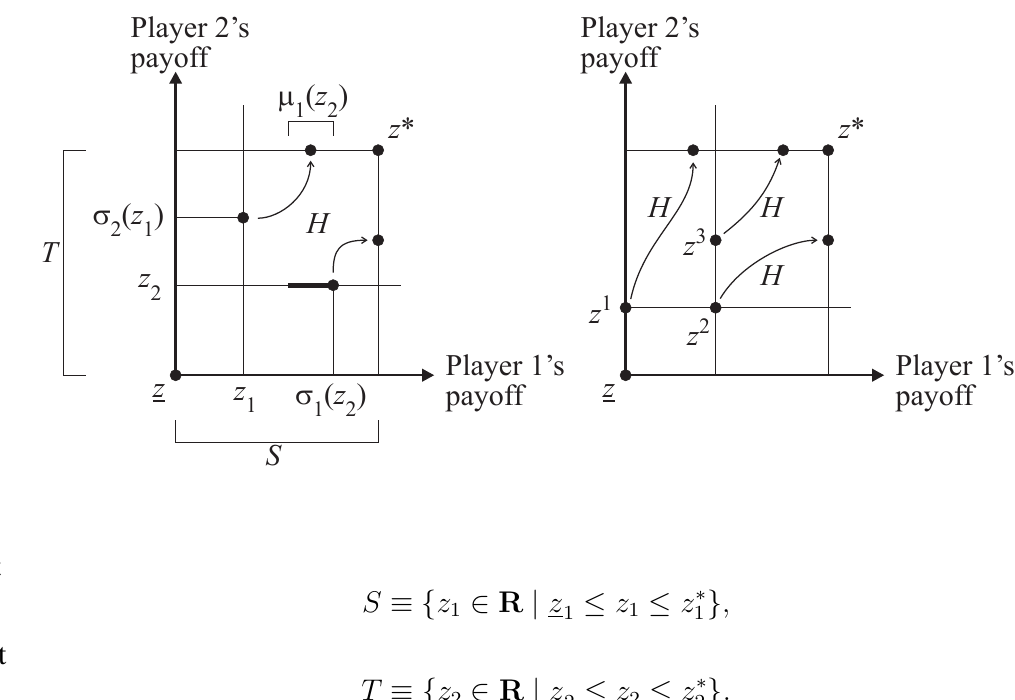
Figure 3. Components of the monotonicity